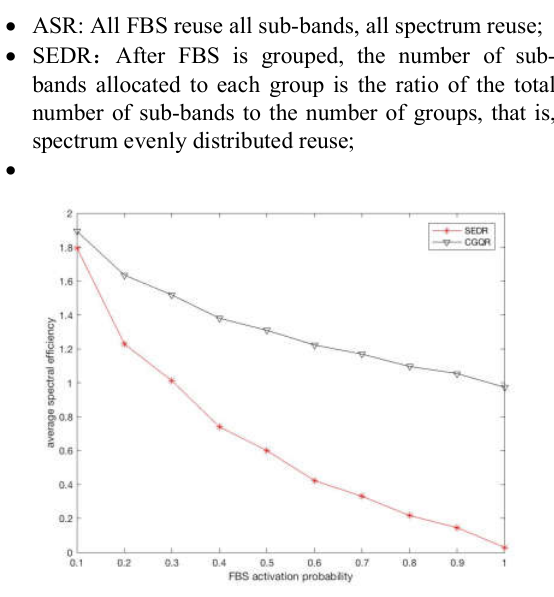
Figure 2. Average spectral efficiency with activation